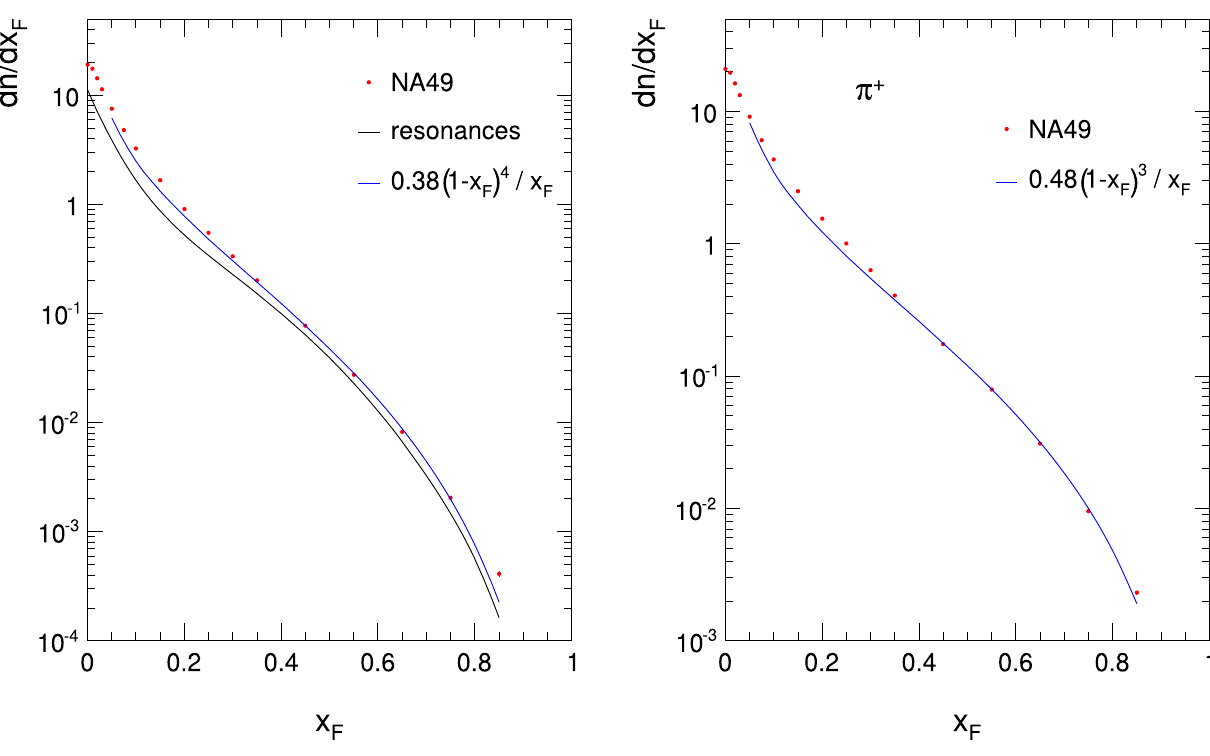
Fig. 197 dn / dx F of π + as a function of x F for the inclusive NA49 data. A fit to the data suggesting the up-quark structure function is